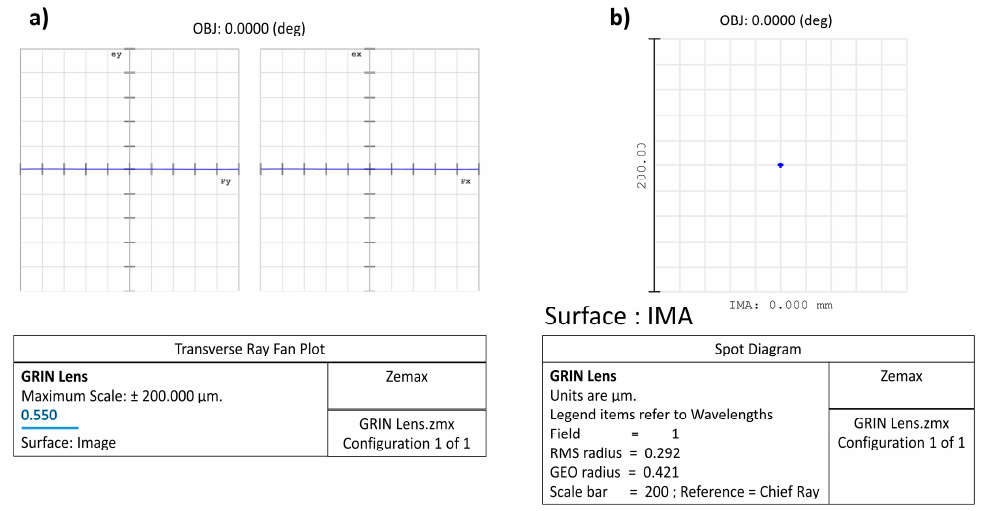
Figure 10. Transverse ray ( a ) and spot diagram ( b ) for the GRIN lens plotted with the same scale of the biconvex lens.